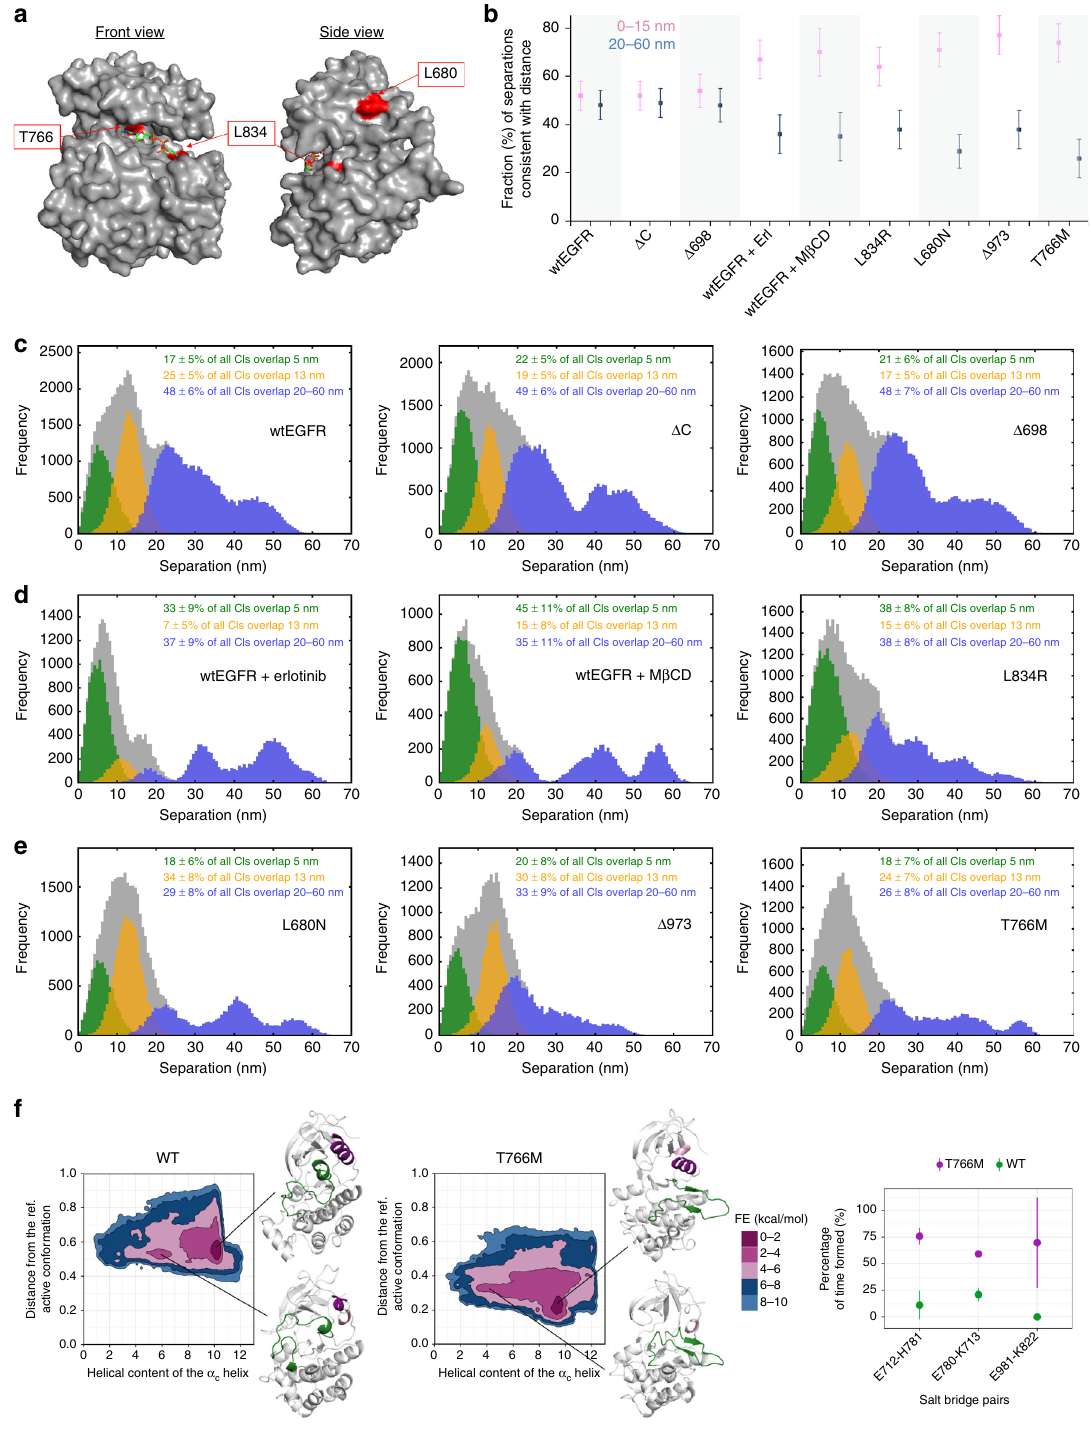
energy minimum populated with structures with a disordered α C shifted towards lower values that correspond to higher disorder